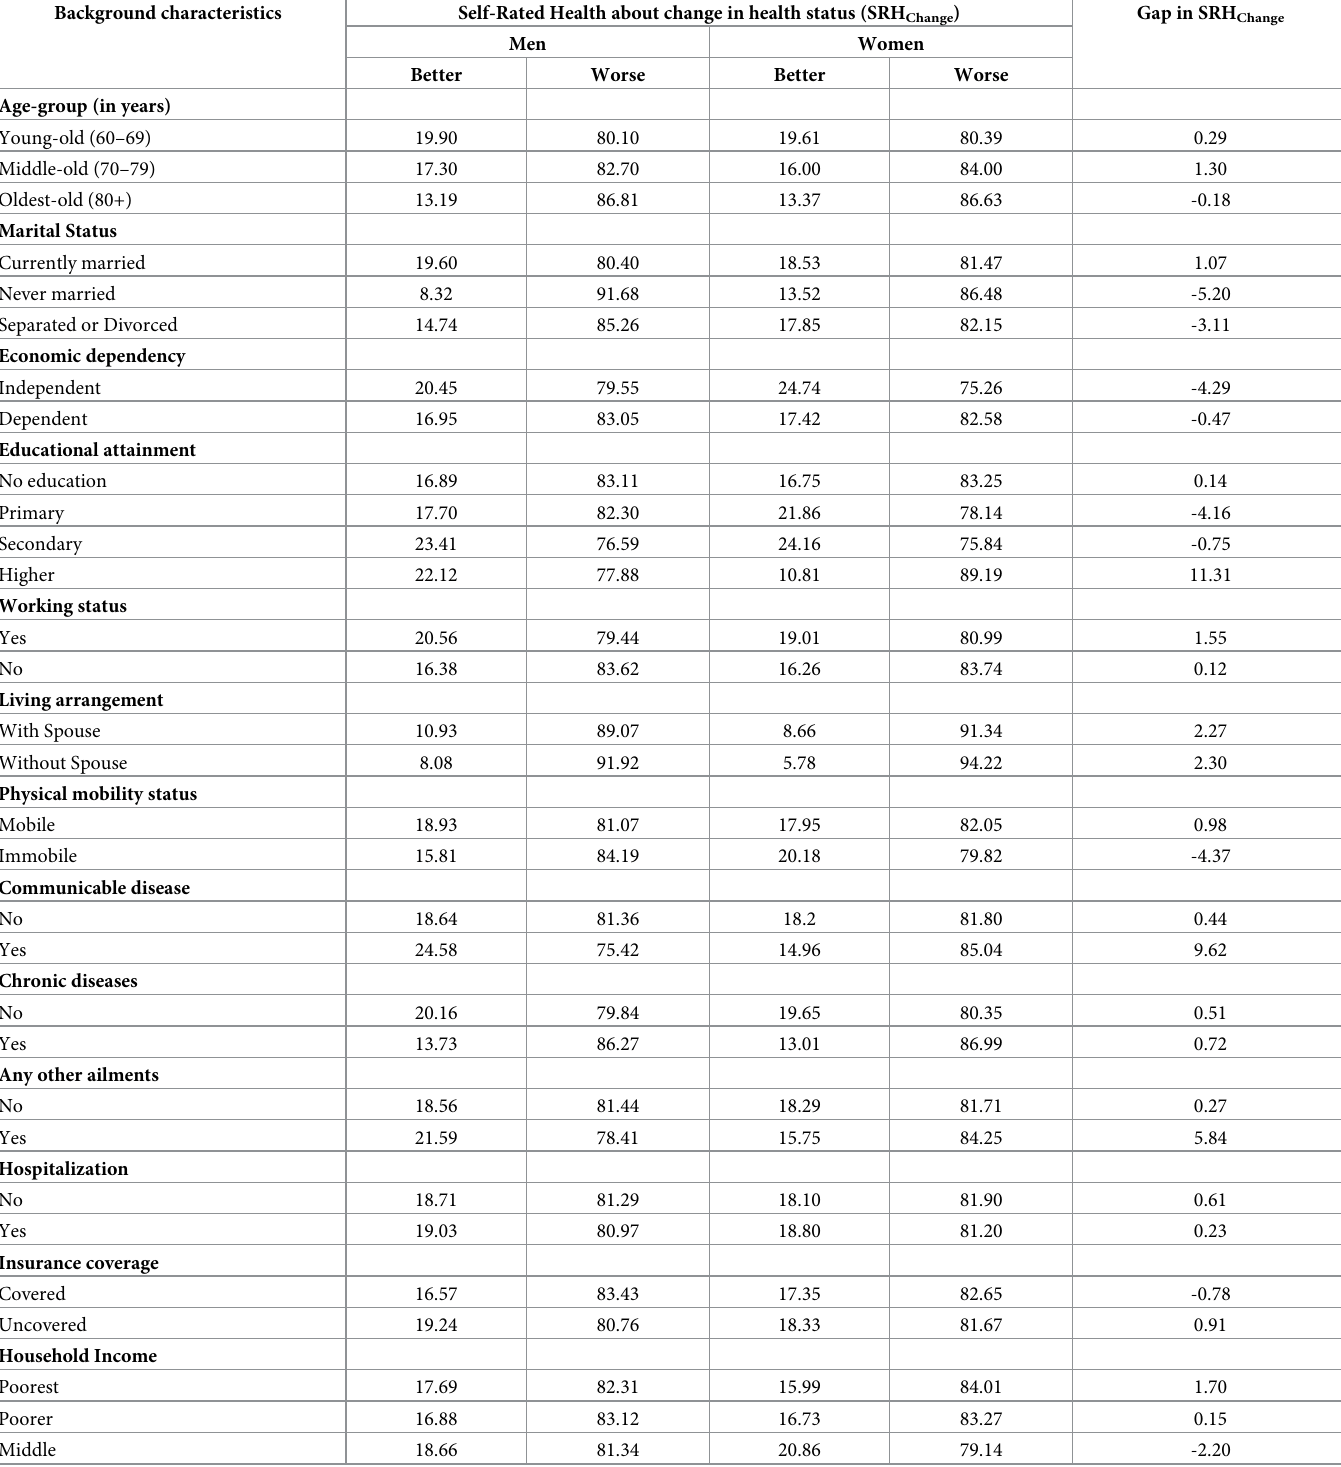
Table 3. Absolute gender gaps (%) in Self-Rated Health (SRH) about change in health status among older adults in India by gender with suitable background char- acteristics, 2017–18 (n = 42,759). Background